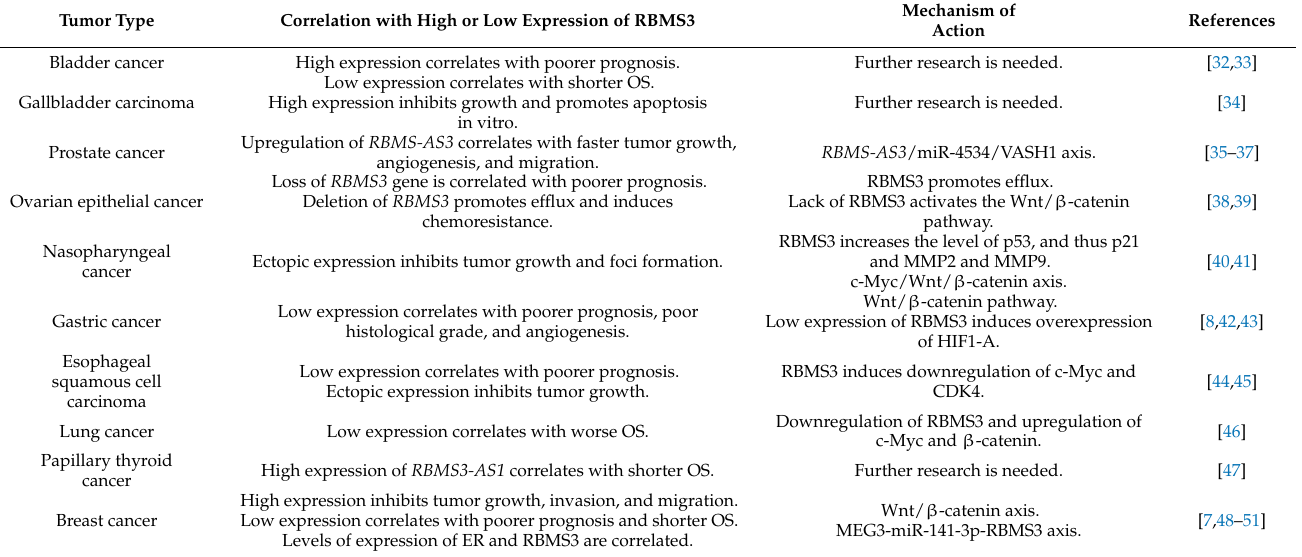
Table 2. Role of RBMS3 in